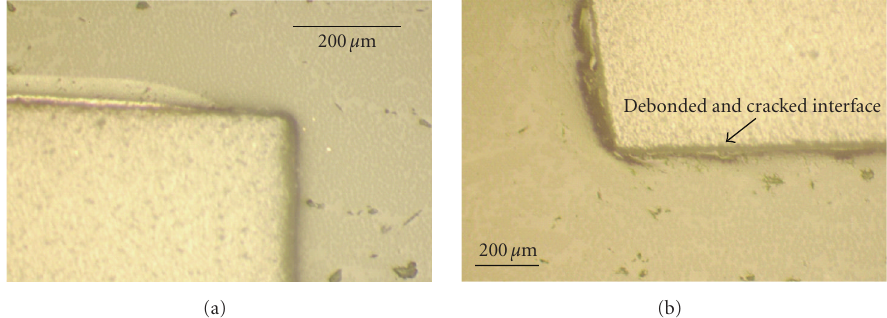
Figure 10: Photomicrographs of the cross-section around the dummy sensor of one virgin sample (a) and of one sample tested until 400 MPa (b).